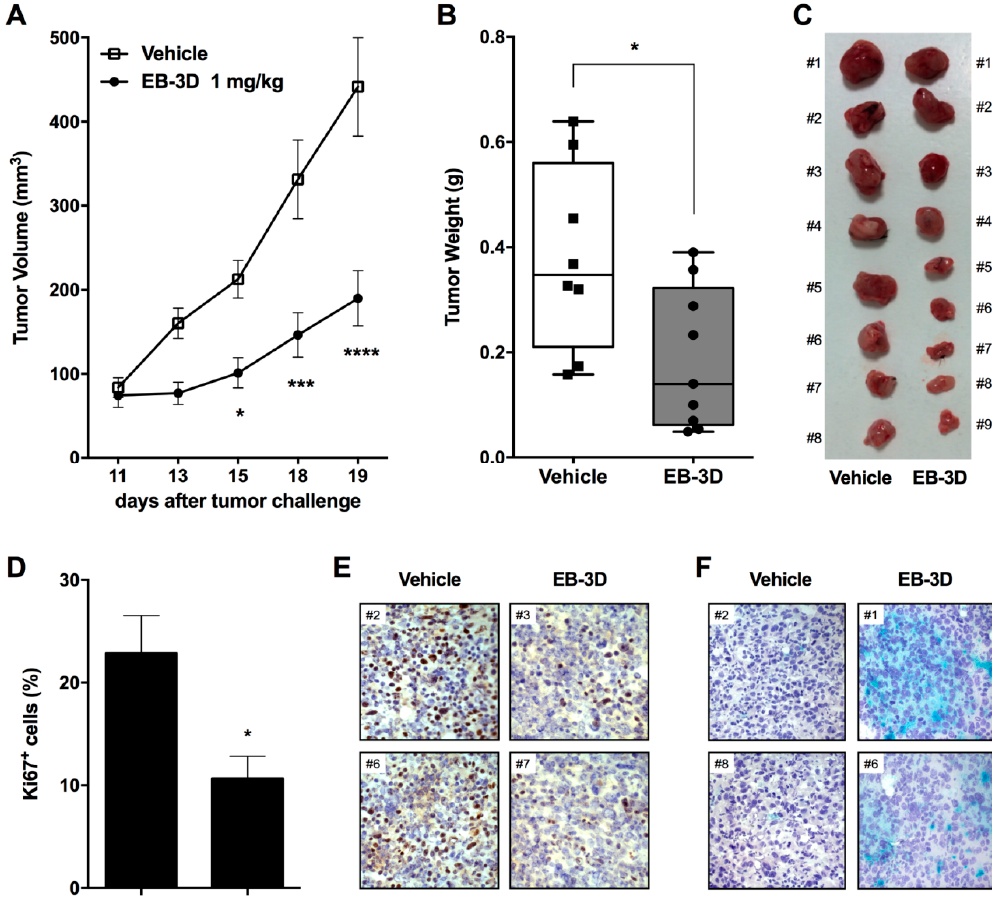
Figure 5. ChoK α inhibition impairs mammary tumor growth in syngeneic orthotopic E0771-C57BL/6 mouse model. ( A ) Average mammary E0771 tumor volume of mice injected with either vehicle (DMSO) or 1 mg/kg of EB-3D ( n = 8/treatment). ( B ) Average weight and macroscopic images ( C ) of